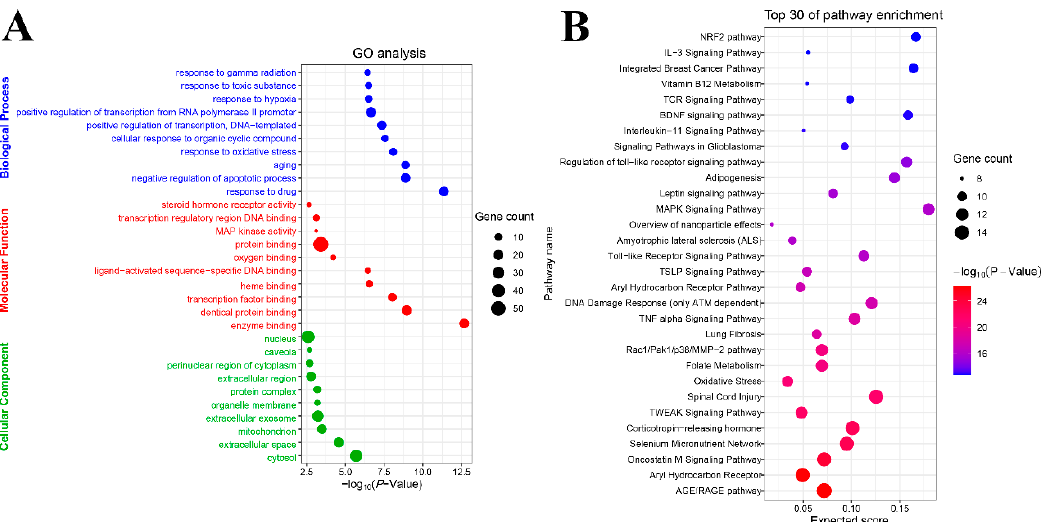
Figure 3. Gene Ontology (GO) and Pathway enrichment analysis of the key targets. GO terms analysis of the 69 target genes containing three aspects, including biological process, molecular function, and cellular component ( A ). Pathway enrichment analysis of the 69 target genes ( B ).